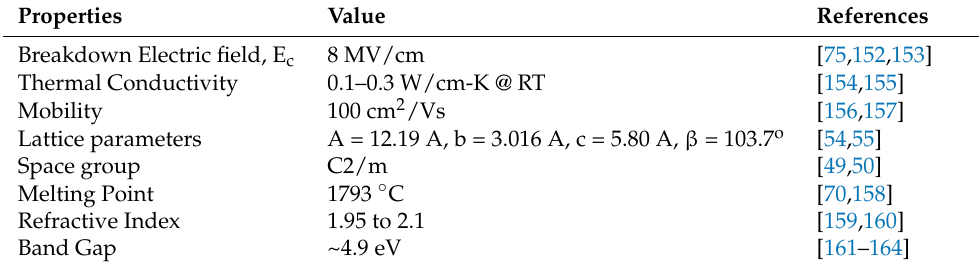
Table 4. Common properties of β -Ga 2 O 3